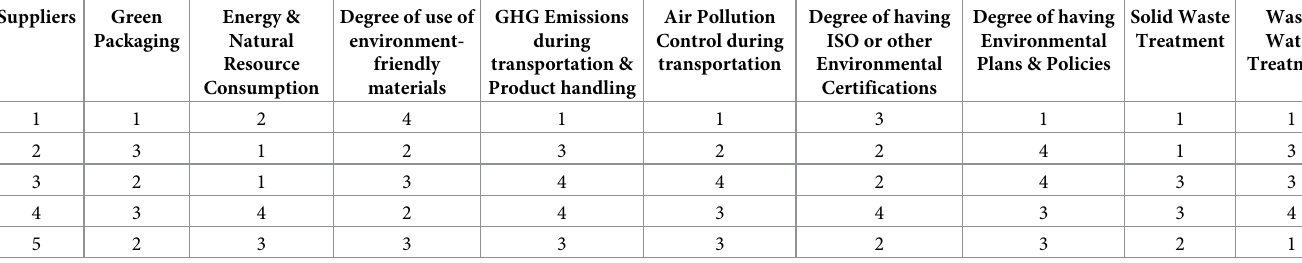
Table 18. Scores of green parameters of suppliers after sensitivity analysis. Suppliers Green